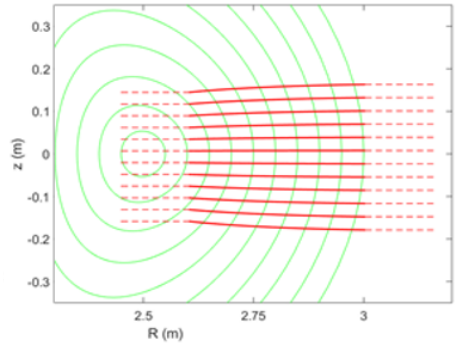
Fig. 8. First (LFS) channel accessibility at WEST nominal magnetic field (3.7 T)